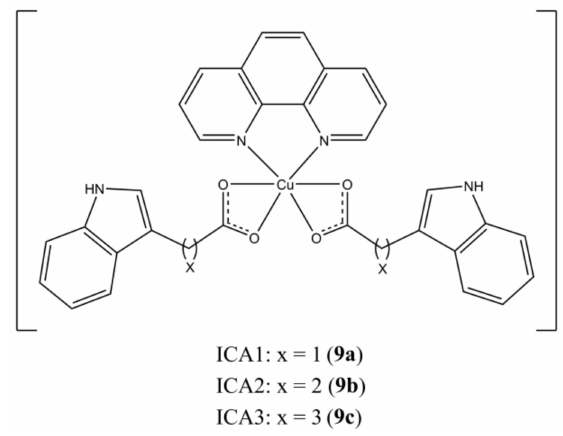
Figure 9. Structures of the [Cu(ICAn) 2 (phen)] complexes.